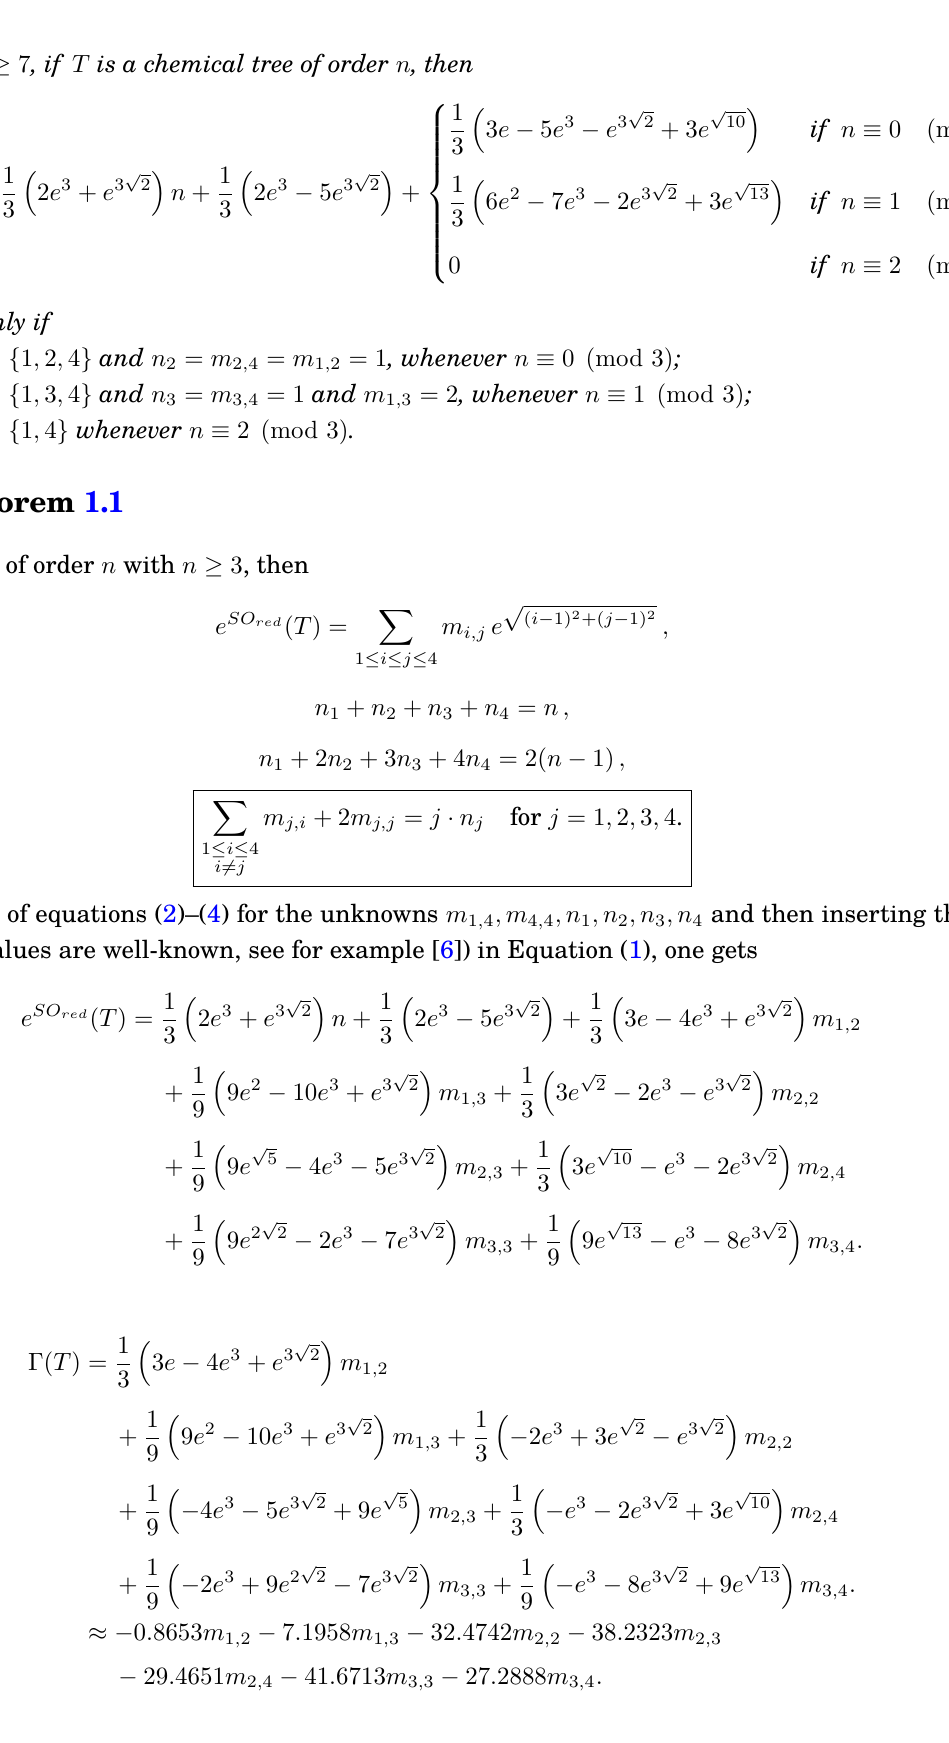
Figure 1: The trees T 1 and T 2 providing a counterexample to Conjecture